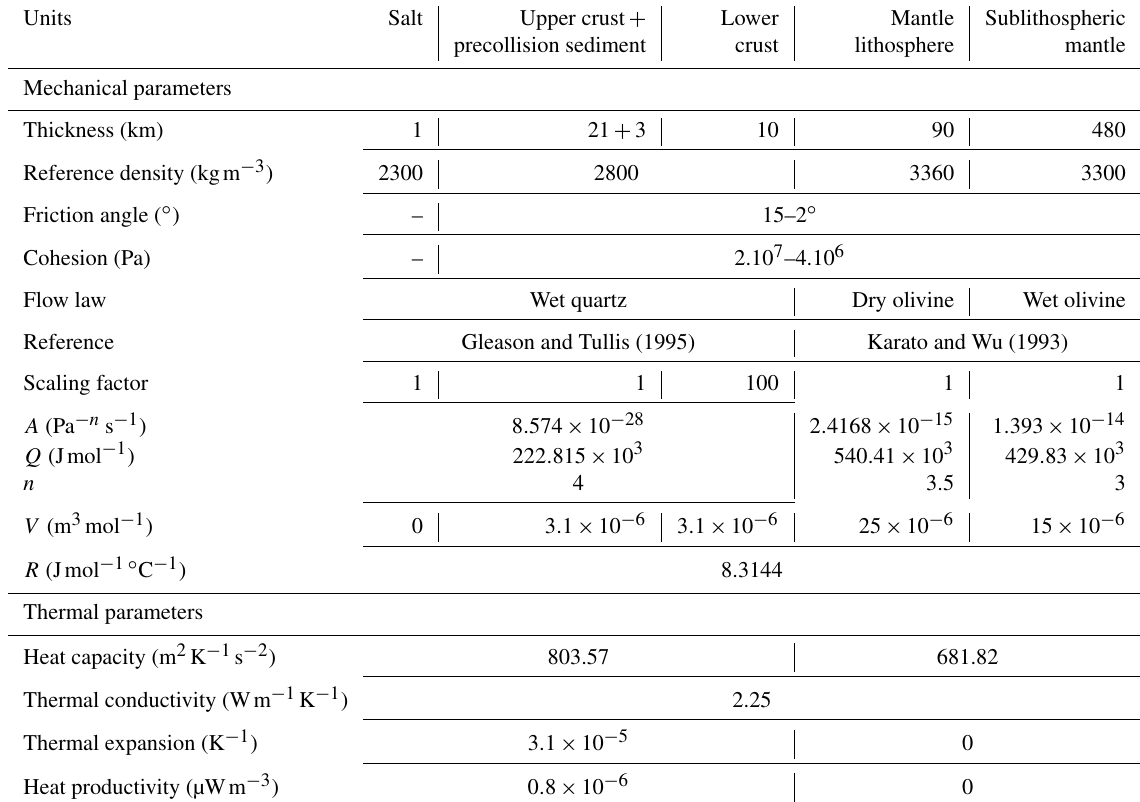
Table 1. Mechanical and thermal parameters used in the models for each material. Units Salt Upper crust + Lower Mantle